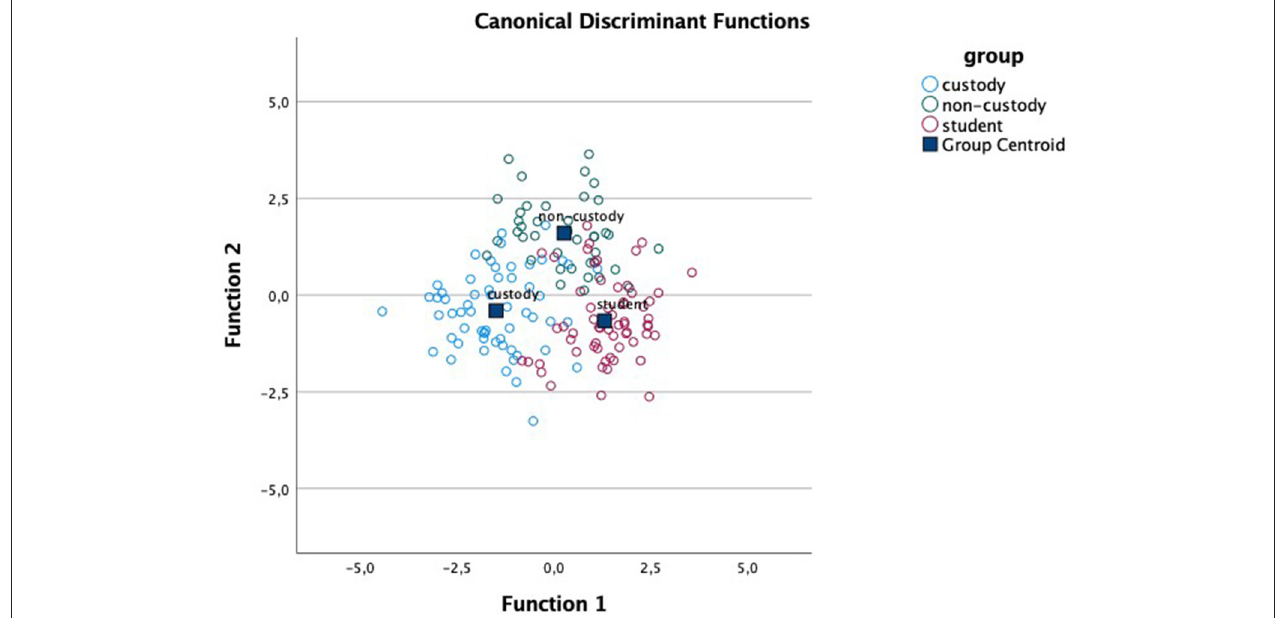
FIGURE 3 | Canonical discriminant functions for the dimension of dominance.